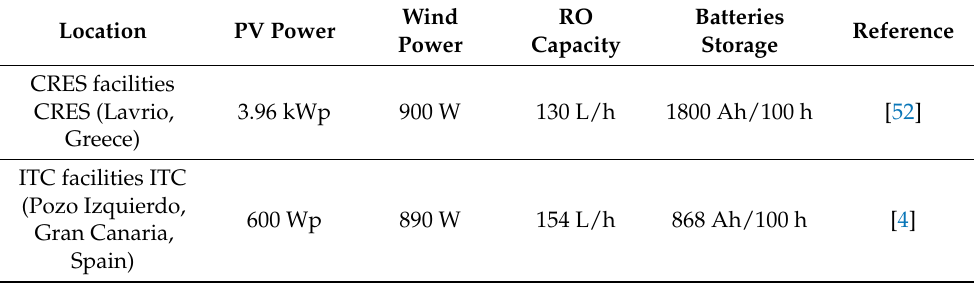
Table 10. Pros and cons of hybrid PV/wind-powered desalination systems. Pros Cons Not all locations are appropriate, since More power at all times, i.e., more energy simultaneous availability of solar and wind per day. resources are required. Two types of generation systems with very different variability in power production, More operation time, i.e., more water maintenance requirements and operation production. performance. More complex control & monitoring systems to Probable reduction in water cost, in check the power balance and reach a stable comparison with a system based on only operation. one RE source.